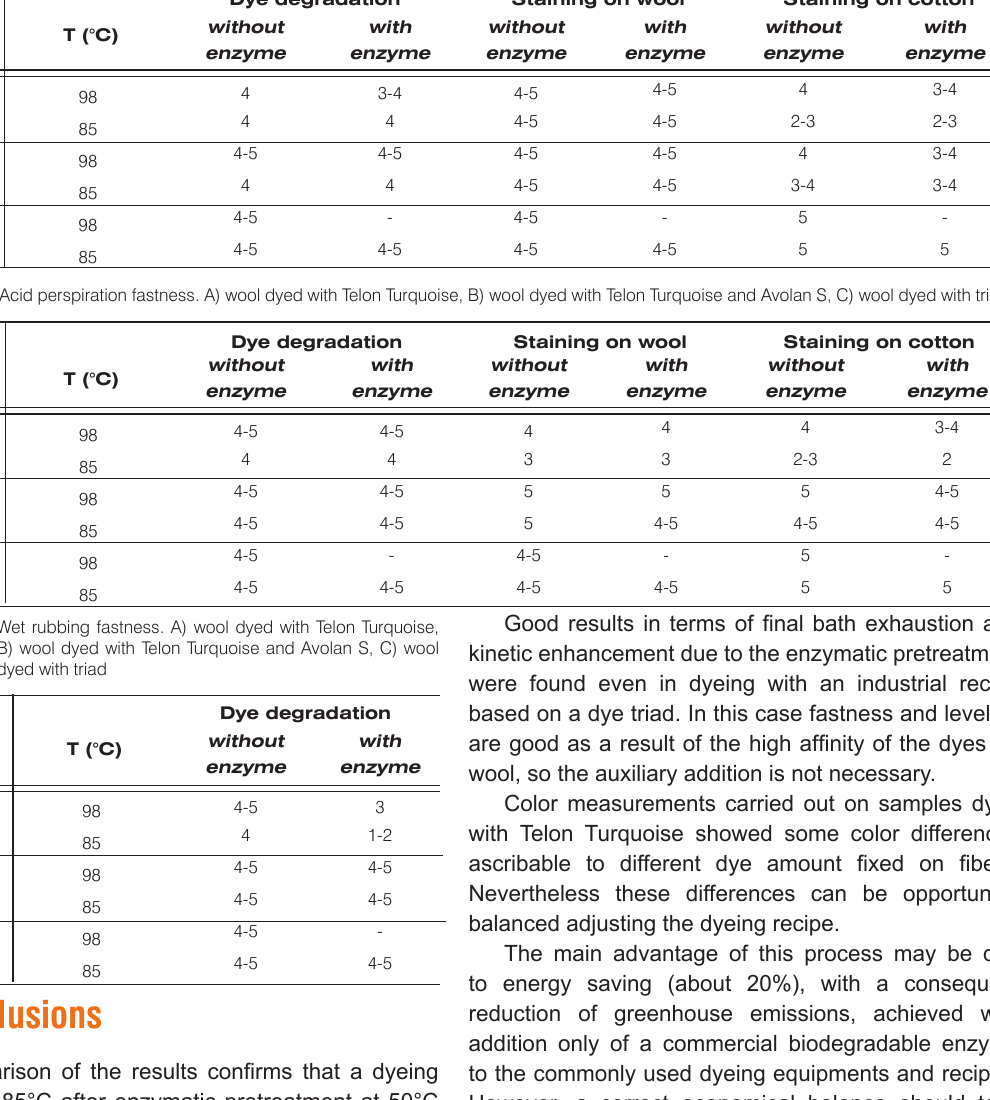
Table 2. Washing fastness. A) wool dyed with Telon Turquoise, B) wool dyed with Telon Turquoise and Avolan S, C) wool dyed with triad Dye degradation Staining on wool Staining on cotton